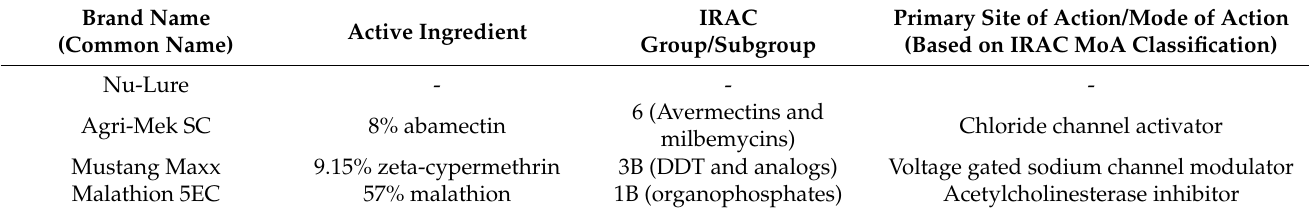
Table 1. IRAC Mode of Action classification for the insecticide active ingredients (abamectin, zeta- cypermethrin, and malathion) that were field-tested against Zeugodacus cucurbitae mixed in Nu-Lure Insect Bait.